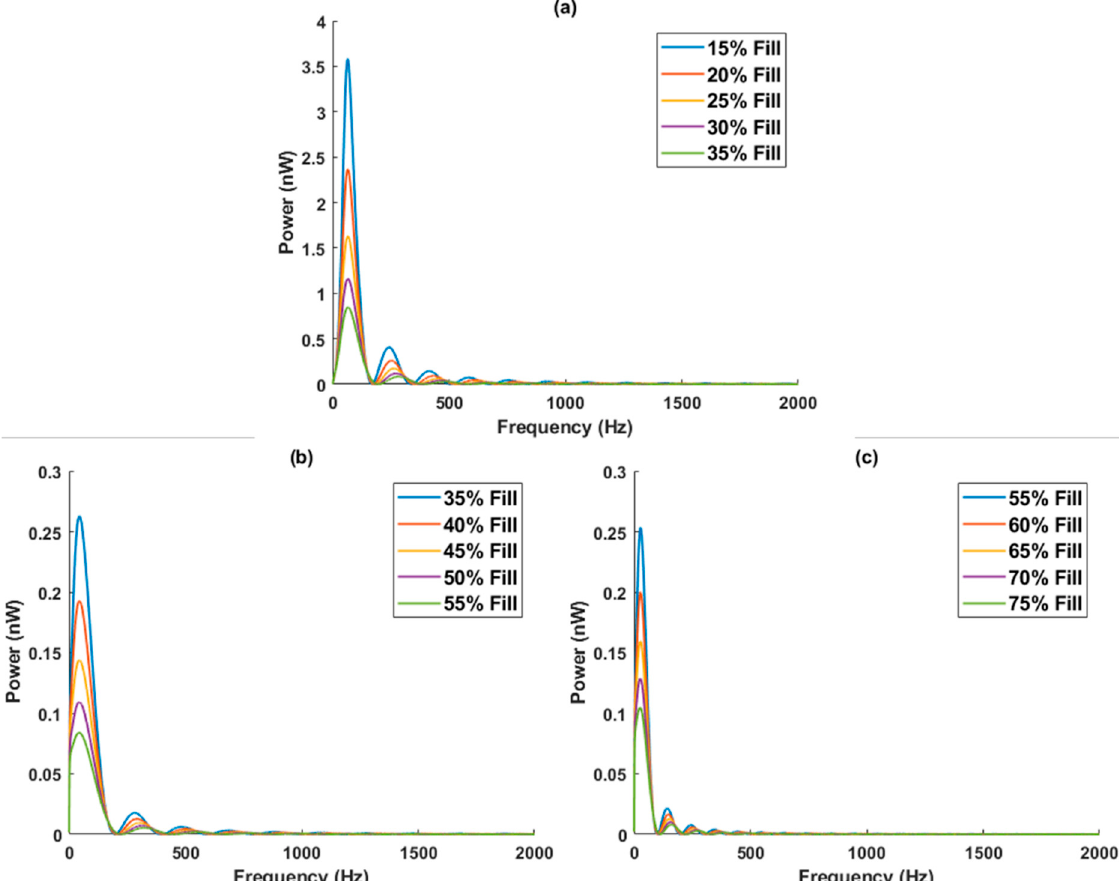
Figure 6. The projected power versus frequency for variations in the fill factor of ± 10% of the nominal value, with other parameters held constant for the ( a ) 25%, ( b ) 45%, and ( c ) 65% samples.